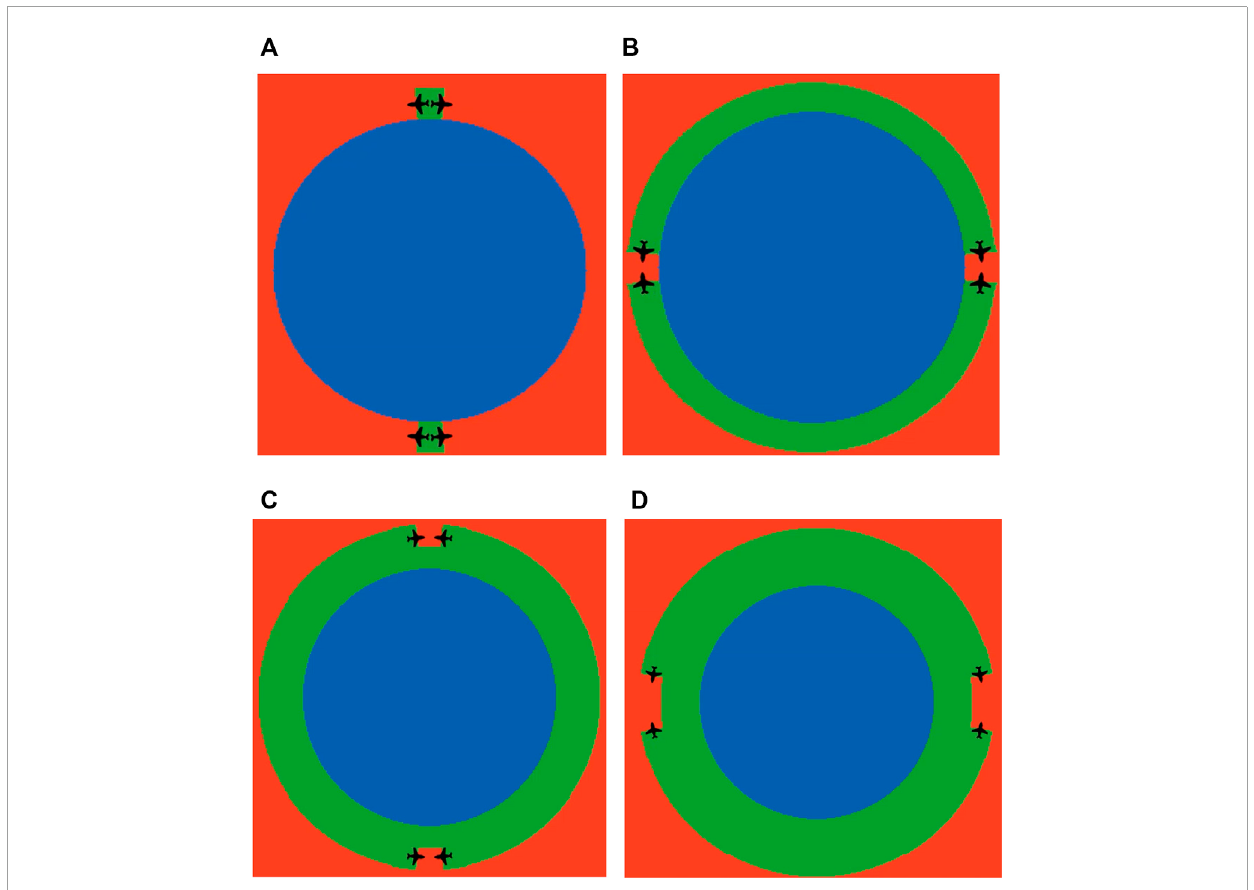
FIGURE 6 Swept areas and protected region status for different times in a scenario where 4 defenders perform the spiral defense pincer sweep protocol. (A) —Beginning of first sweep. (B) —End of the first sweep. (C) —End of the second sweep. (D) —Toward the end of the third sweep. Green areas show locations that were searched and hence do not contain invaders and red areas indicate locations where potential invaders may be present. Blue areas represent locations that belong to the initial protected region that does not contain